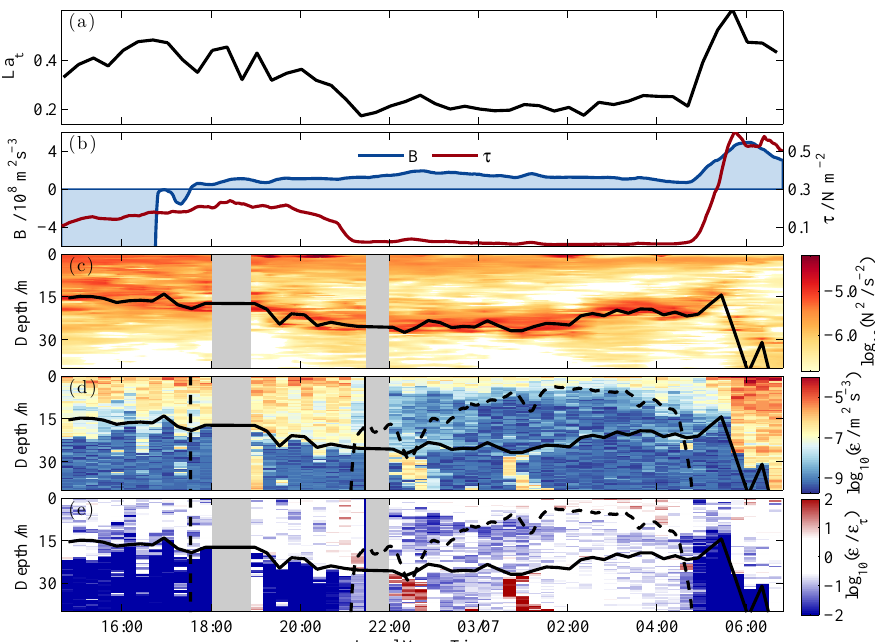
Fig. 9. (a) Turbulent Langmuir number, (b) buoyancy and wind stress forcing, (c) Brunt–V¨ais¨ala frequency N 2 , (d) dissipation (cid:15) and dissipation normalised by the law of the wall (Eq. 5) (d) . The solid black line in (c–e) denote the mixed layer depth D and the dashed line